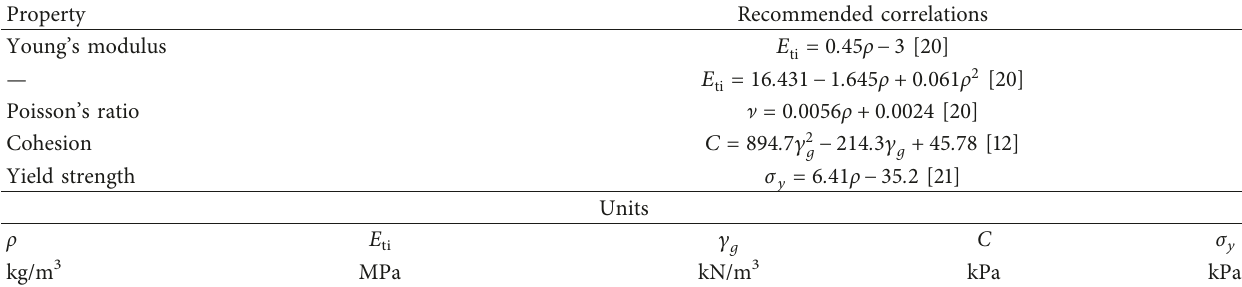
Table 3: Recommended correlations for the EPS geofoam design based on literature.